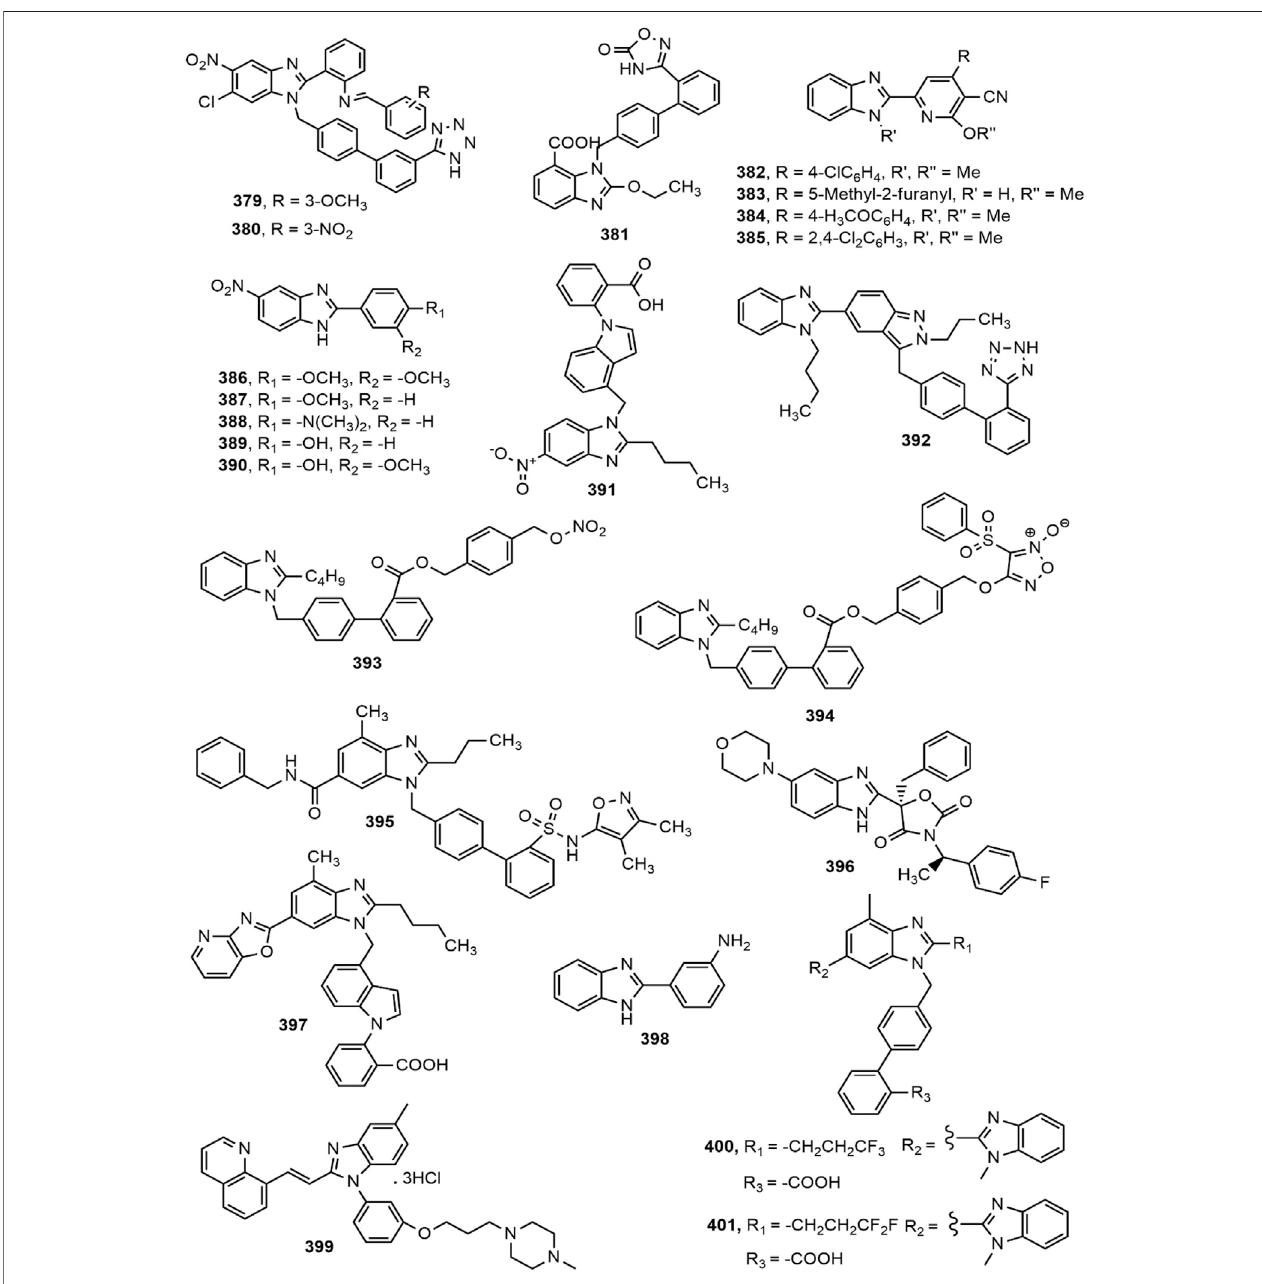
FIGURE 16 | Benzimidazole derivatives with antihypertensive